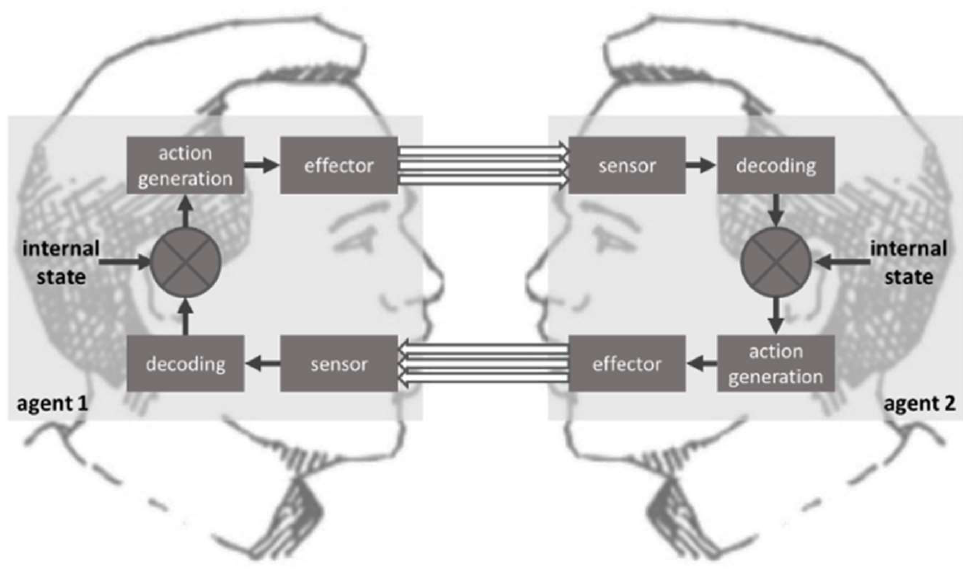
Figure 1. The process of interaction between the two agents. Information is sensed and decoded. In conjunction with the internal state, received messages generate actions through the effector block. An important aspect of interaction is the means of information transfer from sender to receiver.